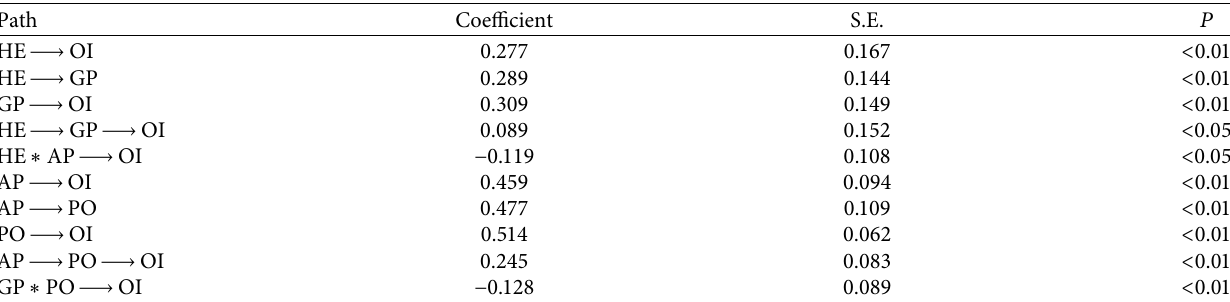
Table 4: Model effect analysis.